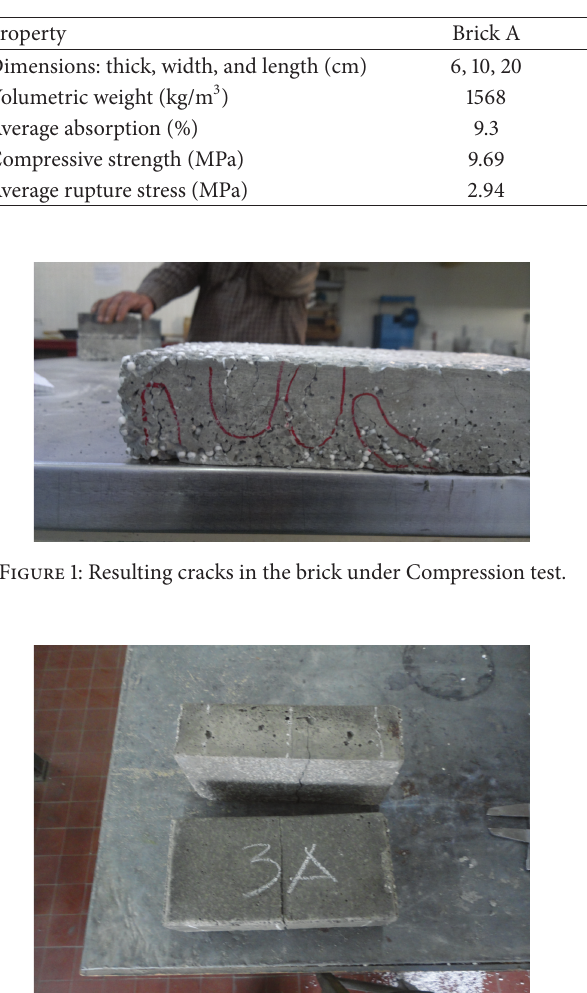
Table 2: Comparative properties of specimen A and B versus reported parameters.